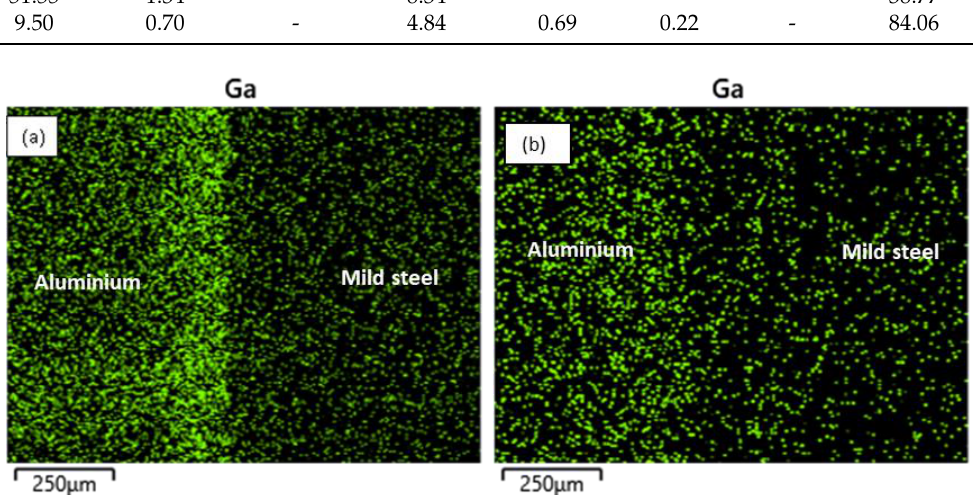
Figure 6. Elemental mapping of Gallium across the bonded metals: ( a ) Sample H; ( b ) Sample E. Figure 7a,b show the micrographs of samples E and F, respectively. As revealed by perature (550 °C) and surface roughness (800 grit) resulted in an increased reaction layer. The increment provided sufficient time that facilitated the growth of the reaction layer